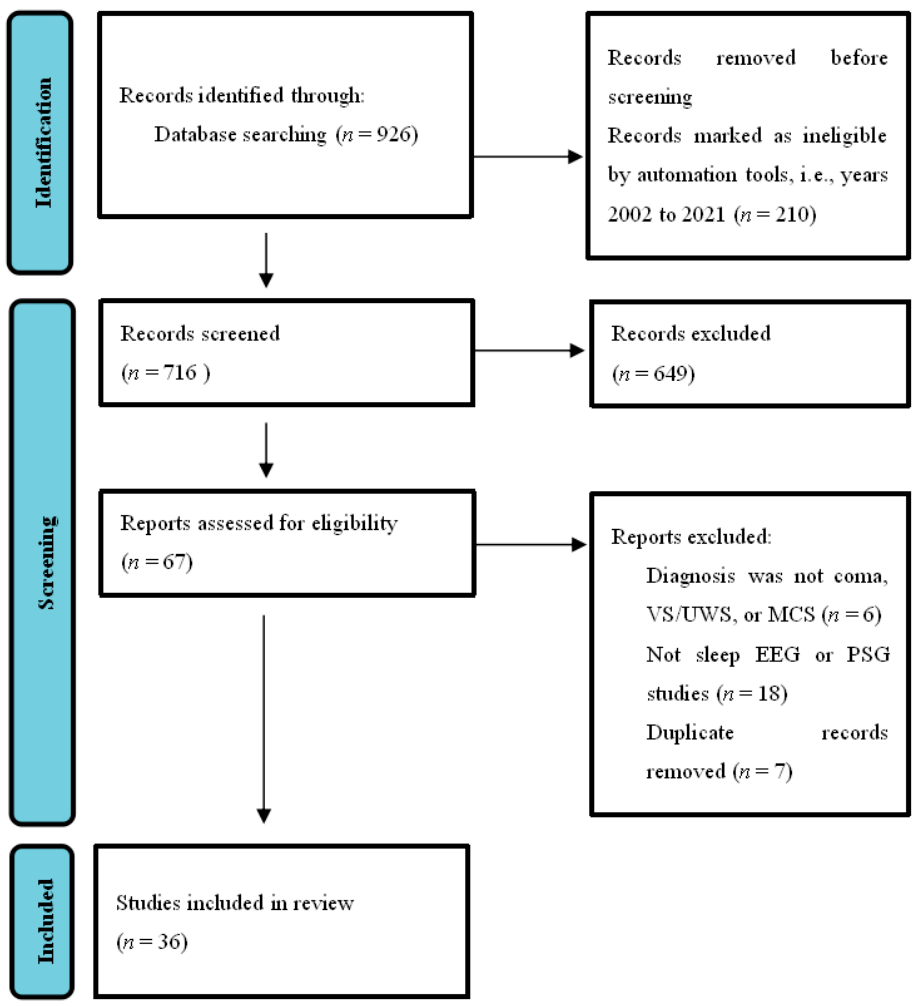
Figure 1. PRISMA flow chart.